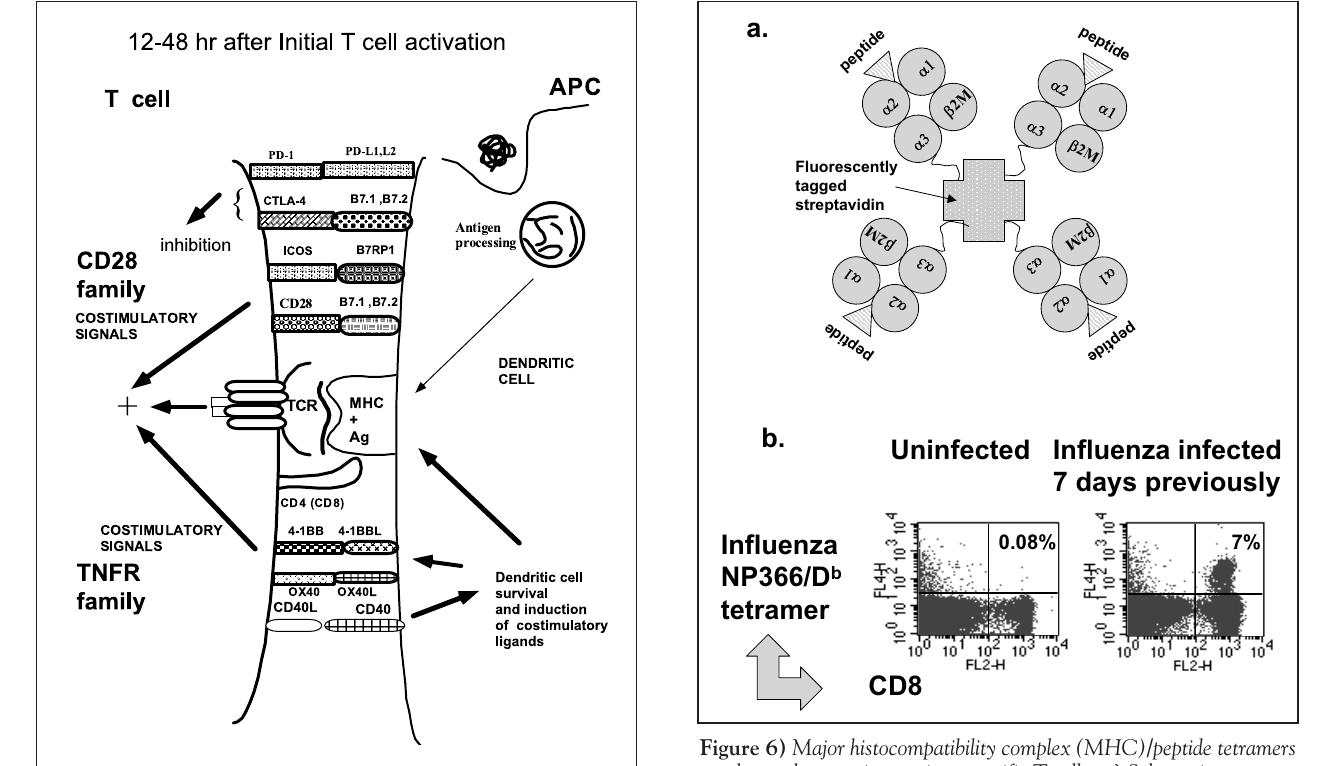
Figure 5) After initial T cell activation, additional costimulatory receptors/ligands are upregulated on the T cell and the antigen pre- senting cell (APC). Details are described in the text and in Table 1. Ag Antigen; ICOS Inducible costimulator; L Ligand; MHC Major histocompatiblity complex; TCR T cell receptor; TNFR Tumour necrosis factor receptor